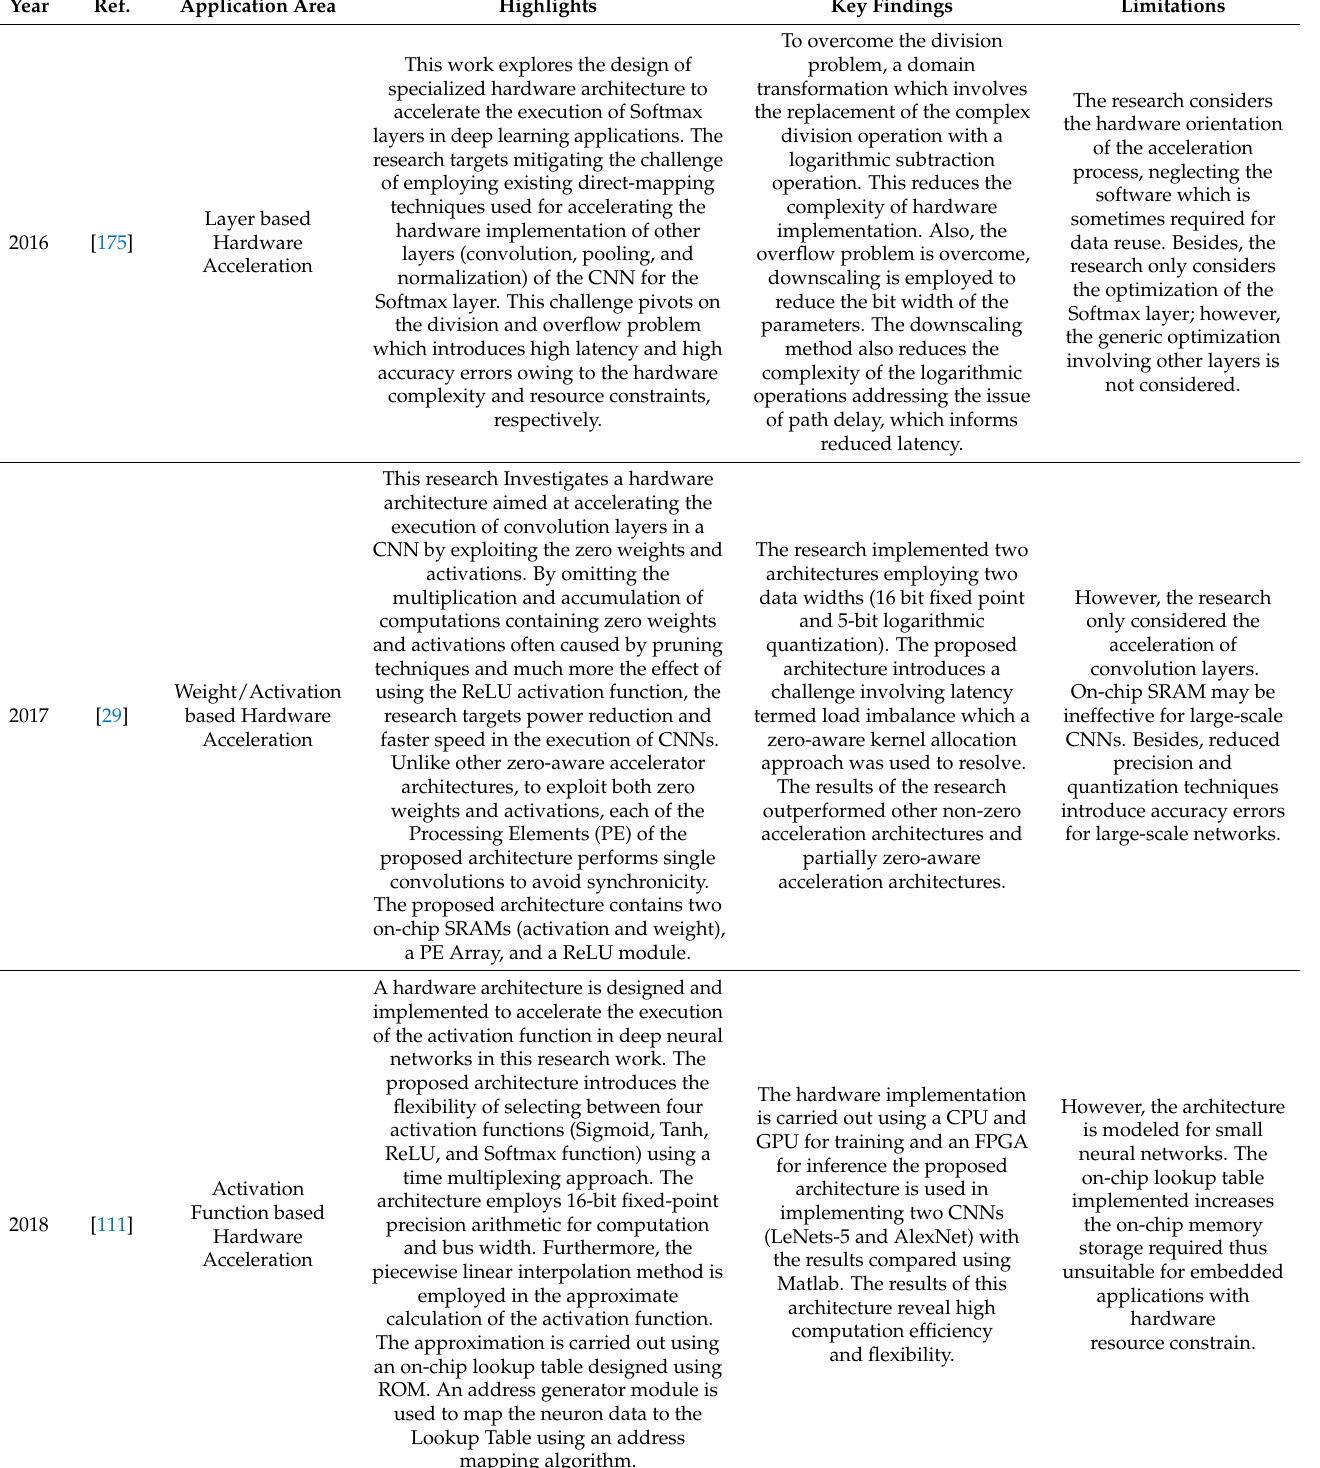
Table 23. Energy-efficient hardware design and